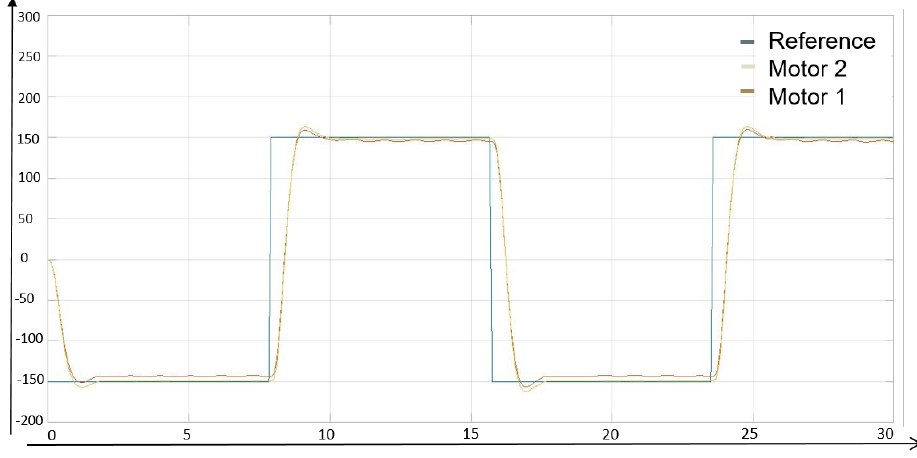
Figure 7. Behavior using PI with optimization values, test 1.